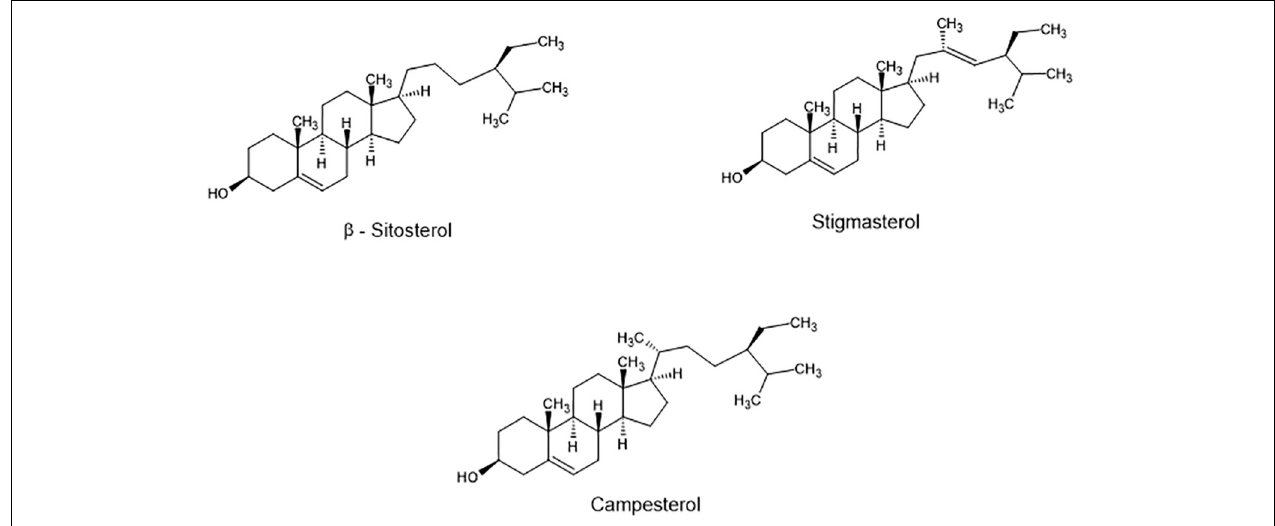
FIGURE 1 | Structure of main phytosterols found in